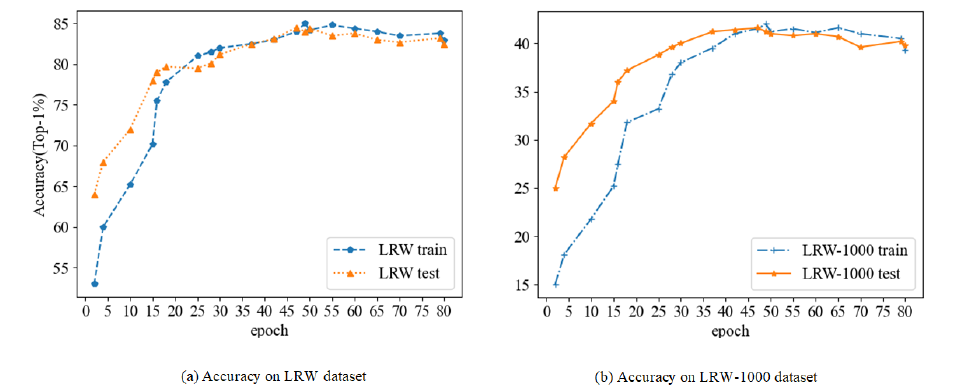
Figure 11. Accuracy of the model in this paper.